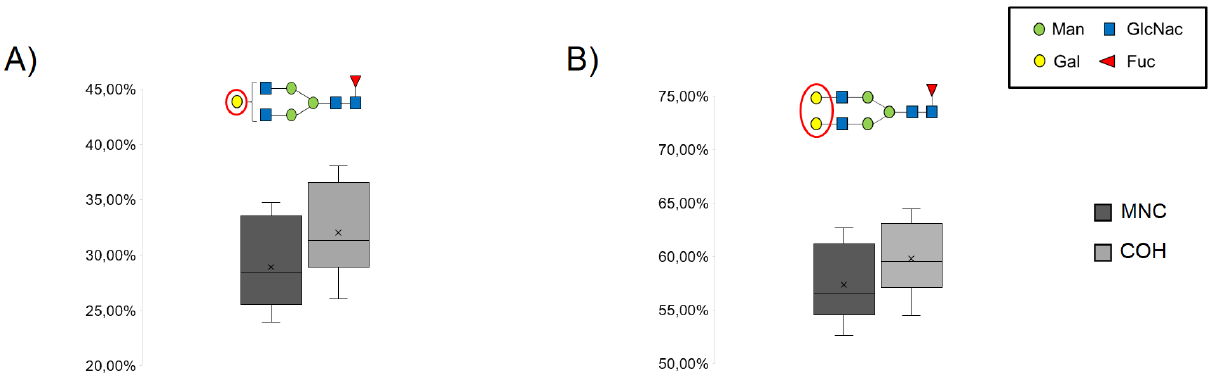
Figure 3: Statistically significant deregulated FF IgG N-glycome derived traits presented as mean±SD (Mann-Whitney U test, p<0,05) between MNC and COH groups of patients. Displayed traits include (A) % of galactosylation and (B) % bigalactosylation of IgG diantennary N-glycans. The minimal N-glycan structure representing each trait is presented in each panel with red circle indicating analyzed features. Abbreviations: Man, mannose; Gal, galactose; Fuc, fucose; GlcNac, N-Acetylglucosamine.